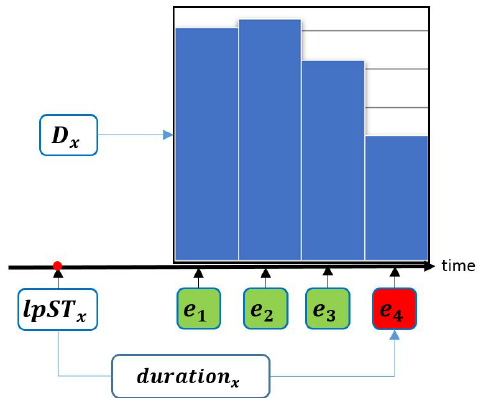
Figure 14. Latest possible start-time for next an activity x